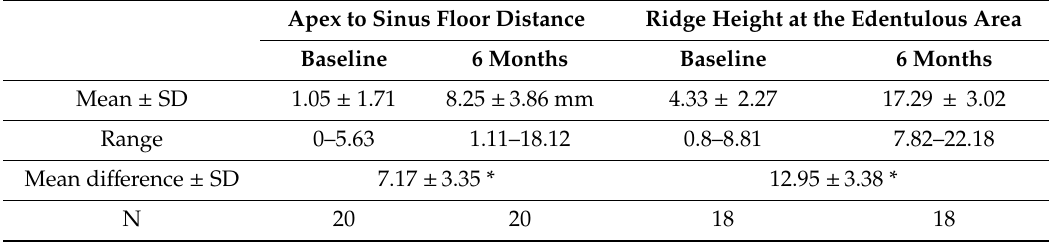
Table 2. Mean measurements at baseline and 6 months after sinus